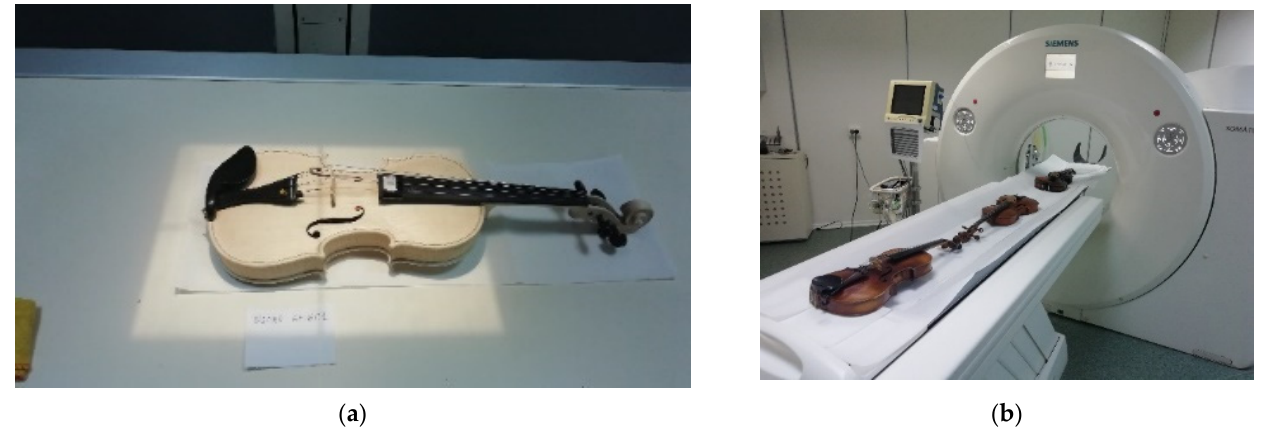
Figure 5. Old violins analyzed using non-invasive and non-destructive methods: ( a ) X-ray of the violin; ( b ) Computed Tomography analysis of old violins.